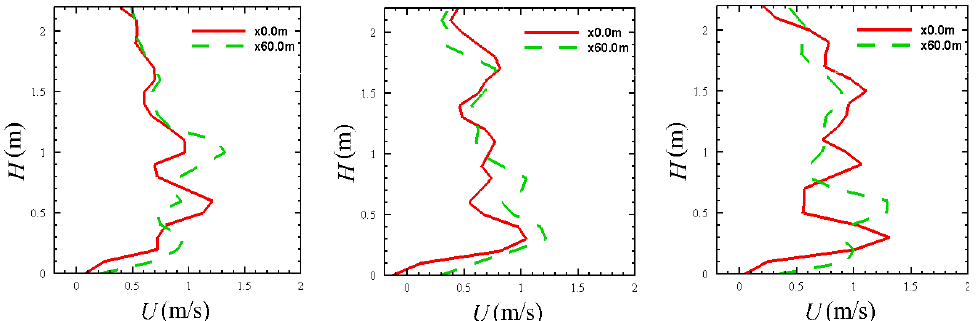
Figure 2. Comparison of flow velocities at inlet and outlet boundary at different times at T = 18.0 s, T = 20.0 s and T = 22.0 s.